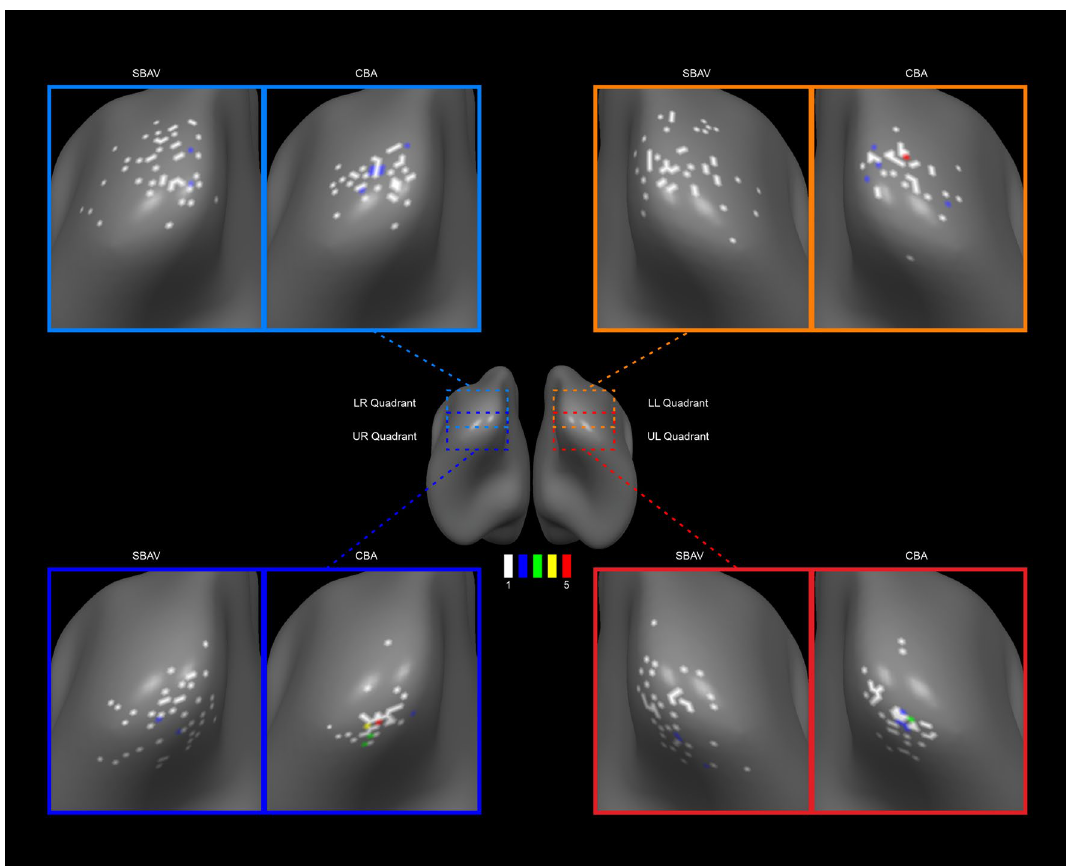
Figure 4. Single-subject peak vertex distribution maps for SBAV and CBA data sets. We mapped single-subject peak vertices for each visual quadrant in surface space for SBAV and CBA data. We then calculated the vertex- wise number of single-subject peak vertices. The color code indicates the number of overlapping single-subject peak vertices per vertex. We observed an increase in the number of overlapping single-subject ROI peak vertices per vertex after macroanatomical alignment (CBA). The number of single-subject peak vertices per occipital vertex for each visual quadrant before and after macroanatomical alignment (SBAV and CBA) ranged between 1 and 5. Thus, a higher number indicates an improved alignment precision of single-subject ROI peak vertices. LR lower right visual quadrant, LL lower left visual quadrant, UL upper left visual quadrant, UR upper right visual